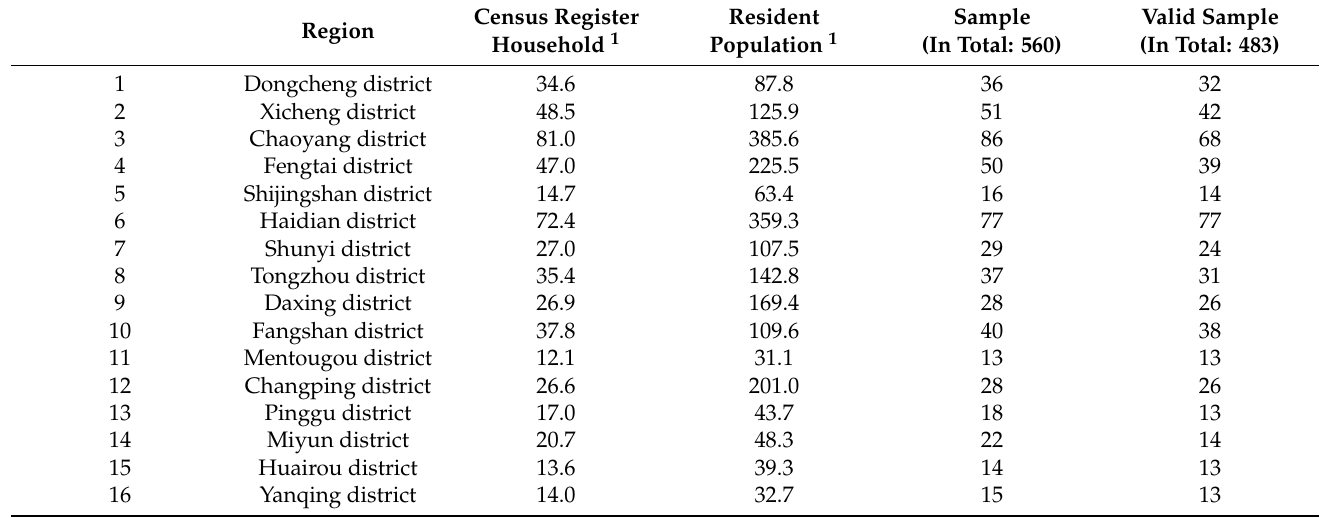
Table 7. Population of region sample.